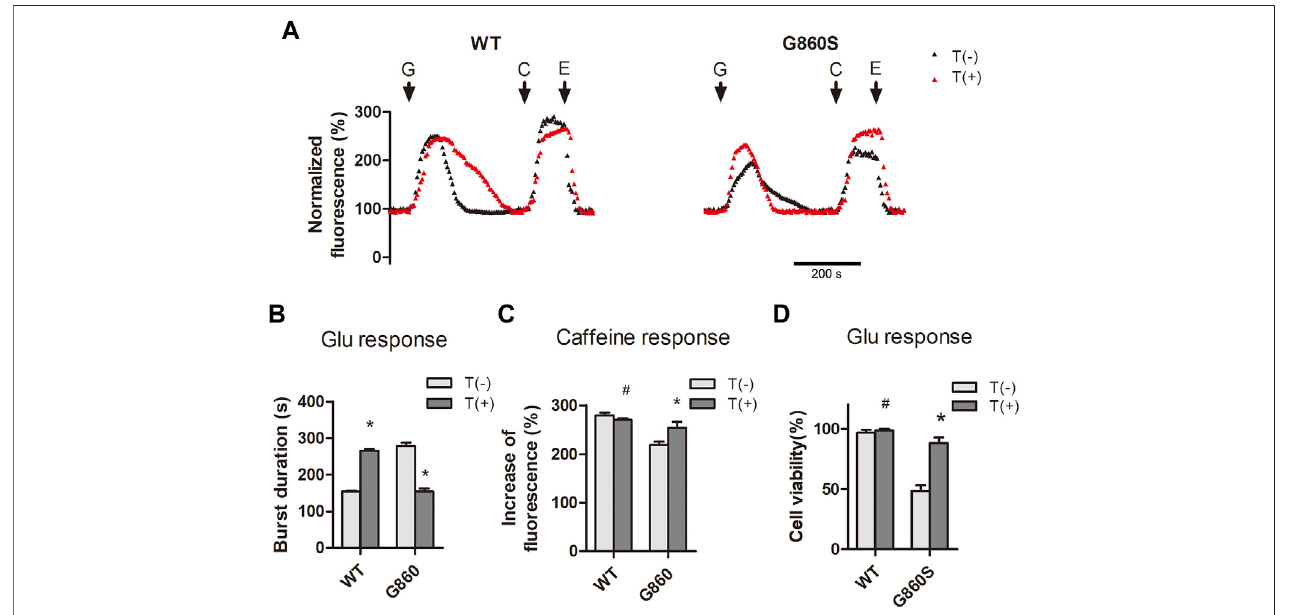
FIGURE 6 | Inhibition of GOF-type pump leakage reduces ER Ca 2+ depletion and attenuates glutamate-induced excitotoxicity. (A – C) : Thapsigargin inhibits pump leakage of G860S mutant. Representative normalized fl uorescence of cytoplasmic Ca 2+ by Furo-4 AM (A) . The addition of glutamate (G), caffeine (C), and EGTA (E) is indicatedwithblackarrows. (B) :Quanti fi cationofthe[Ca 2+ ] cyto clearance ef fi ciencyinresponse toglutamate. T:Thapsigargin. (C) :Quanti fi cation ofthe[Ca 2+ ] ER storage in response to caffeine. (D) : Thapsigargin rescues the cell viability of the G860S mutant under glutamate loading. (B – D) * p < 0.05 compared with no-thapsigargin treatment, # p > 0.05 compared with no-thapsigargin